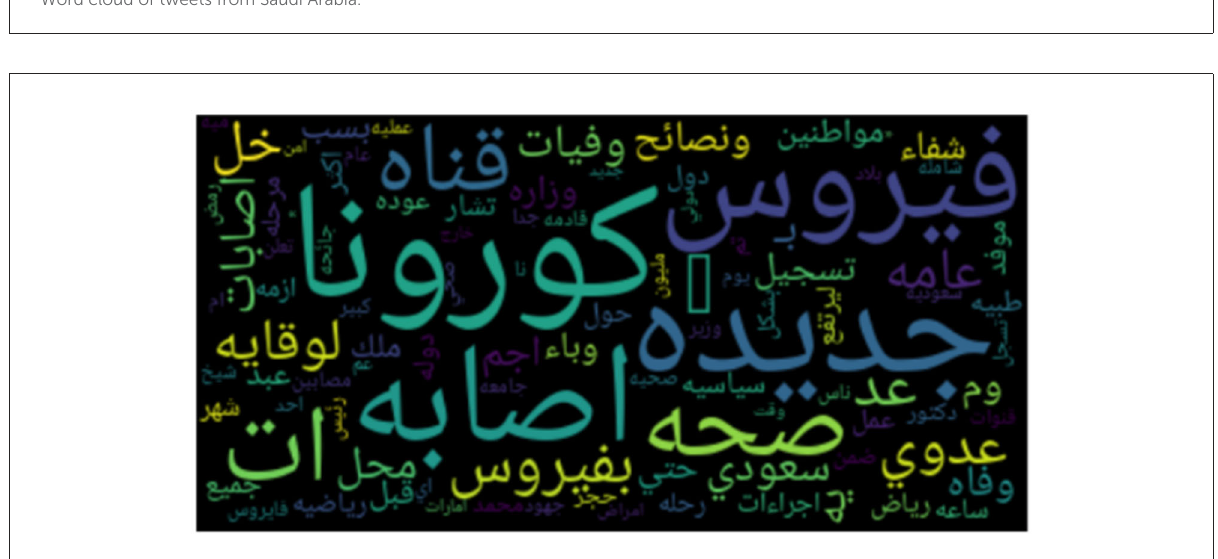
FIGURE4 Word cloud of tweets from United Arab